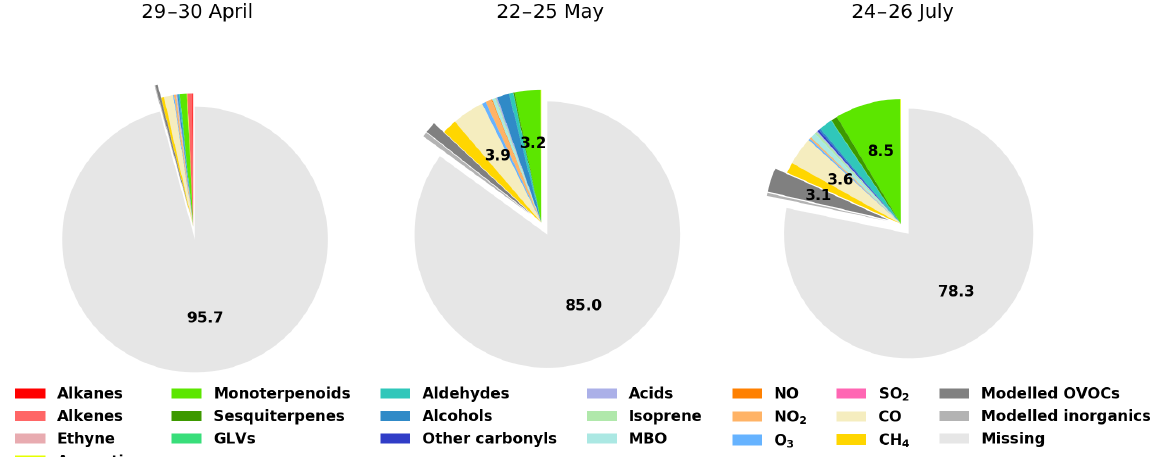
Figure 9. Contributions of various compounds and groups of compounds to the measured total OH reactivity ( R exp ). For clarity, labels for fractions smaller than 2.0% have been